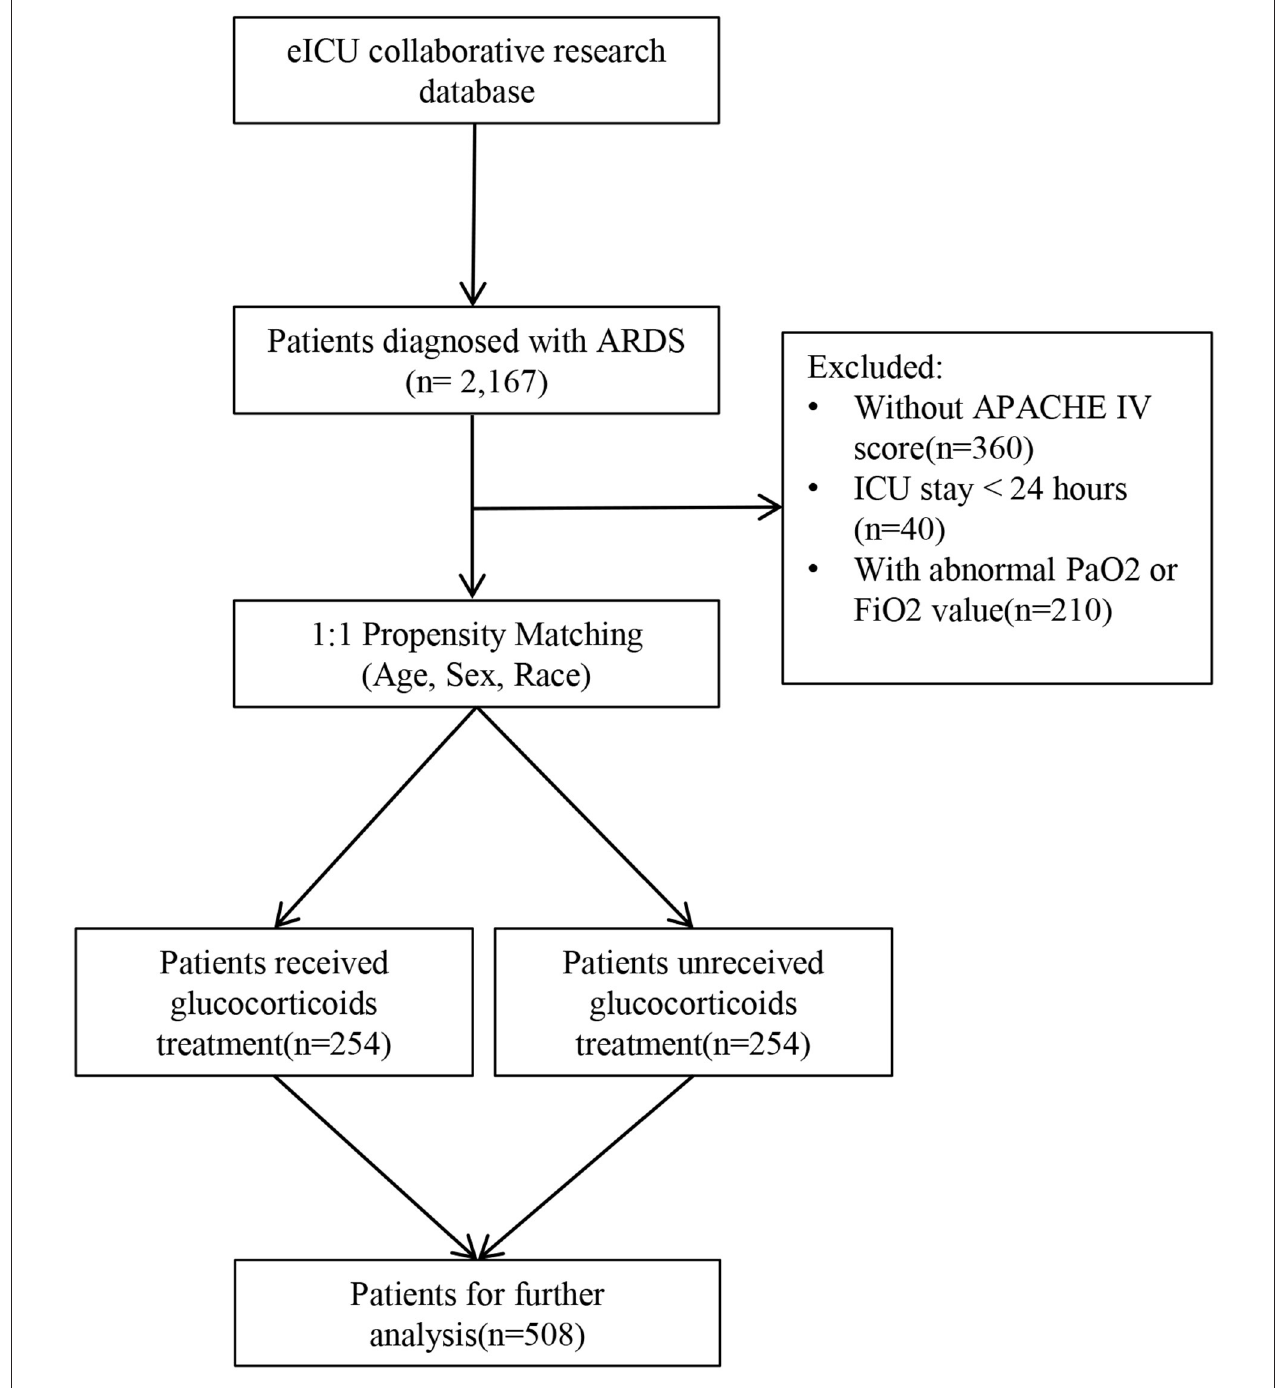
FIGURE 1 | Inclusion and exclusion flowchart of the study. Trajectory Function in JM Sub-models in JM are combined by trajectory function (Formula.2). The X ij represents the trajectory of longitudinal biomarker and the Z i represents the treatment (GCs) for ith patients. The trajectory function represents the linear relationship between observation times for patients t ij +